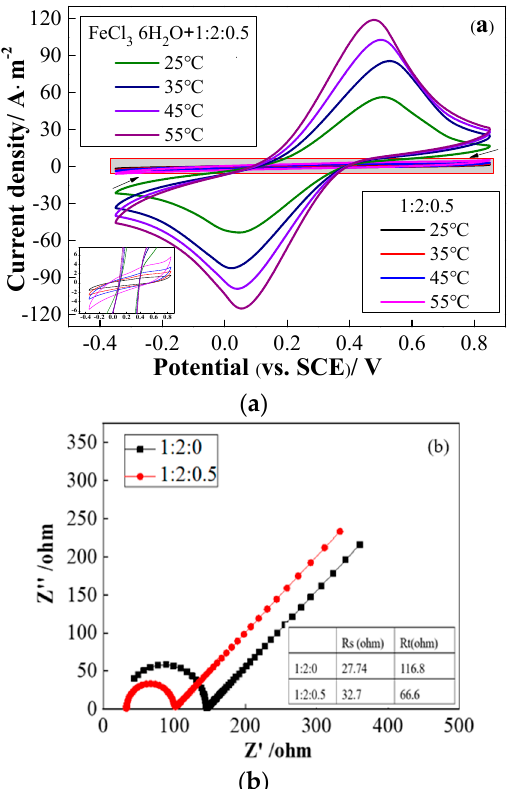
Figure 4. Cyclic voltammogram of the DESs with 0.1 mol·L − 1 FeCl 3 ·6H 2 O at the scan rates of ( a ) 50 mV·s − 1 ; ( b )100 mV·s − 1 .